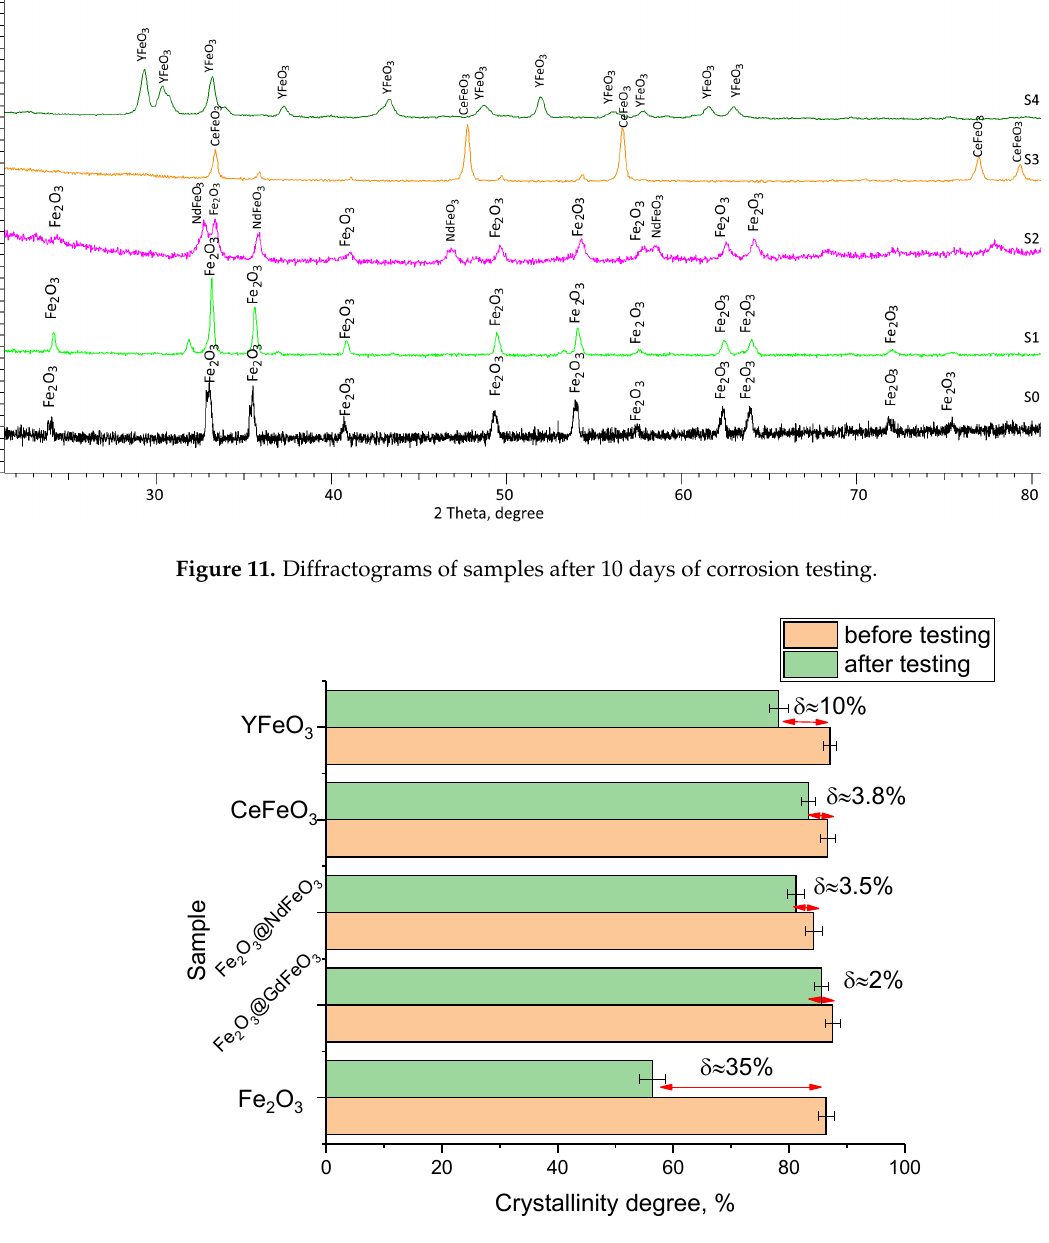
Figure 12. Results of the change in the structural ordering degree of the studied samples after corrosion tests (the data are given in comparison with the values in the initial state).